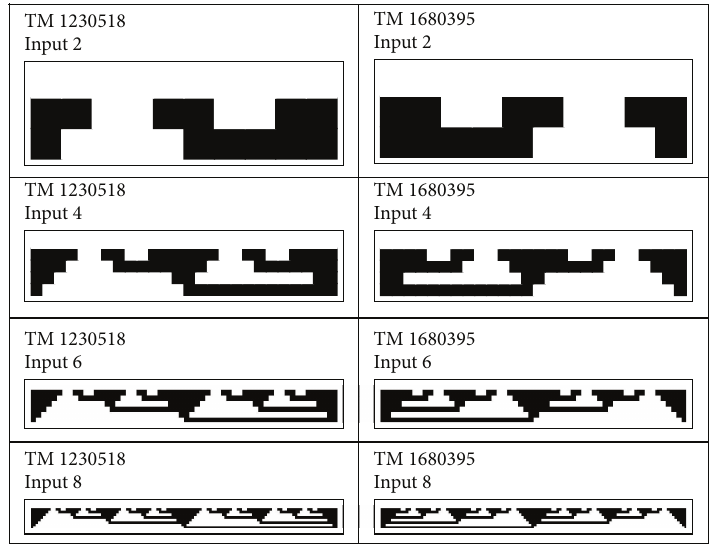
Figure 8: Symmetric